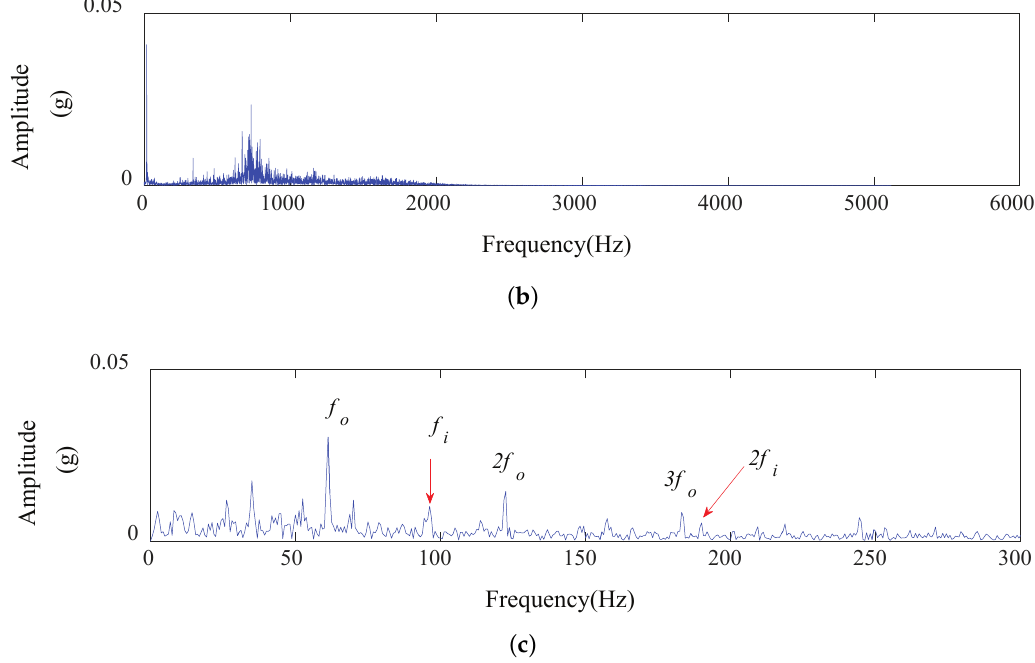
Figure 21. Results of the proposed WOGS algorithm: ( a ) Time domain waveform. ( b ) Frequency spectrum. ( c ) Envelope spectrum.